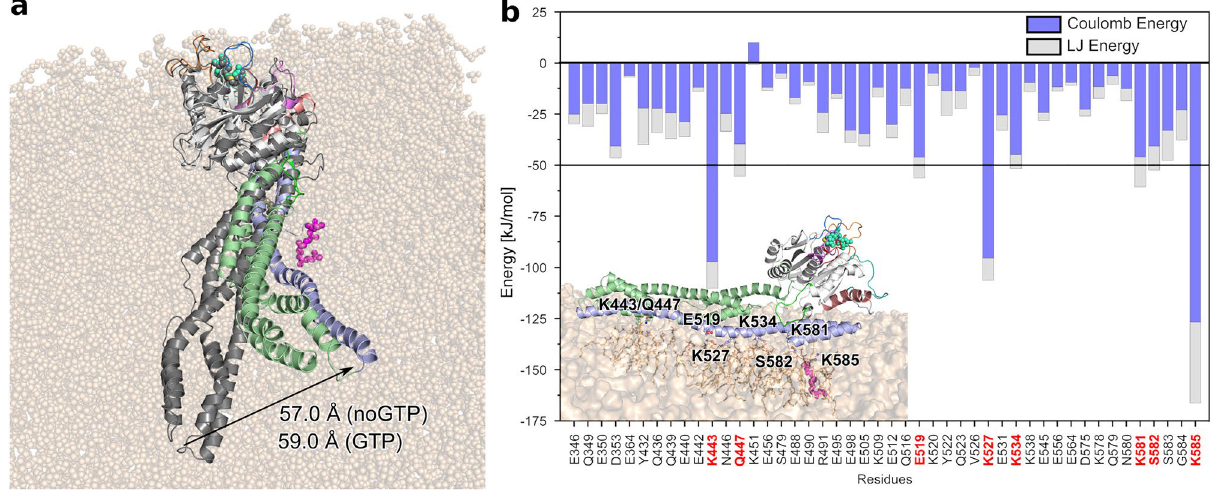
Figure 7. Hinge motion and energies of the strongest interactions between mGBP2 residues and the POPC membrane. ( a ) The conformation with the highest distance to the start structure, as measured by the distance of L480 with respect to the MD start structure (in gray), is shown and the distances for mGBP2 GTP mem and mGBP2 noGTP mem are given. During the motion the tip of the M/E domain detaches from the membrane surface. ( b ) The mGBP2 GTP mem —membrane energies are decomposed into Coulomb (blue) and Lennard–Jones (gray) contributions. The residues with a total interaction below − 50 kJ/mol (horizontal black line) are highlighted with red labels and considered as key residues for interacting with the membrane. They are all part of the M/E domain, as can be seen in the structure figure in the lower left